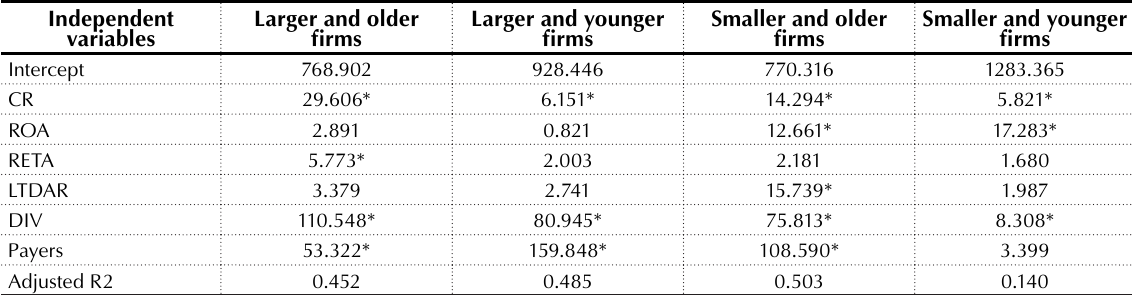
Table 4. Analysis of covariate to test the market reaction on fundamental signal Independent